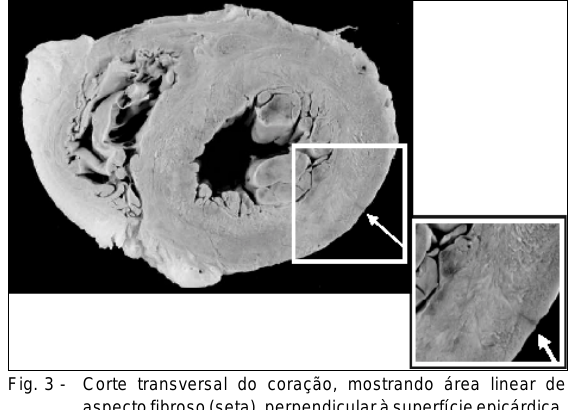
Fig. 3 - Corte transversal do coração, mostrando área linear de aspecto fibroso (seta), perpendicular à superfície epicárdica, que se estende pelo miocárdio, a partir da região subepicárdica em direção ao endocárdio (destaque).